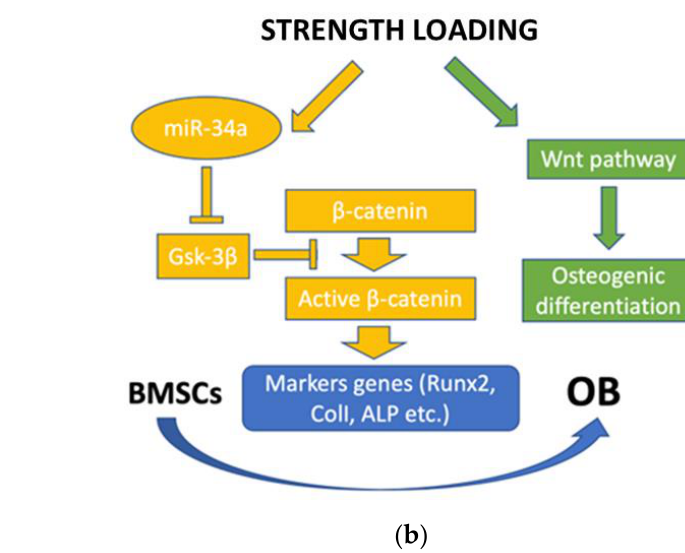
Figure 1. ( a ). Through the suppression of its target PDCD4 (Programmed Cell Death 4), which is caused by an intracellular increase in miRNA-21, the transcription factor c-fos is stimulated, thus increasing the protein synthesis involved in bone remodeling. ( b ). Summary scheme of one of the action mechanisms of miRNA-34a by which, following the application of a loading force in vitro and in vivo, allows osteogenic differentiation and OB (Osteoblast) differentiation from BMSCs (Bone Marrow Stem Cells). The arrows indicate a stimulating effect, the blunt ones instead of inhibition.